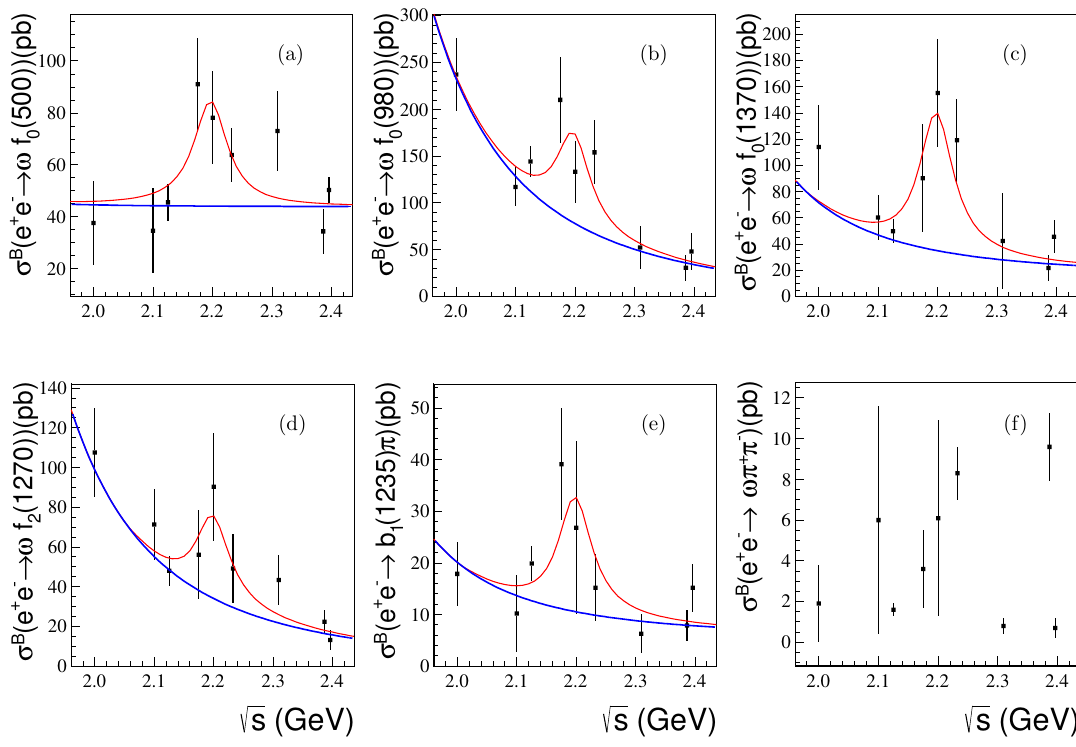
Figure 10 . Fits to the intermediate processes of e + e − → ωf 0 (500) (a), ωf 0 (980) (b), ωf 0 (1370) (c), ωf (1270) (d), b (1235) π (e). Points with error bars are the measured Born cross sections, the 2 1 red curves are the total fit results, and the blue curves denote the contributions of non-resonant processes. Plot (f) displays the contribution from the phase space process e + e − → ωπ + π −